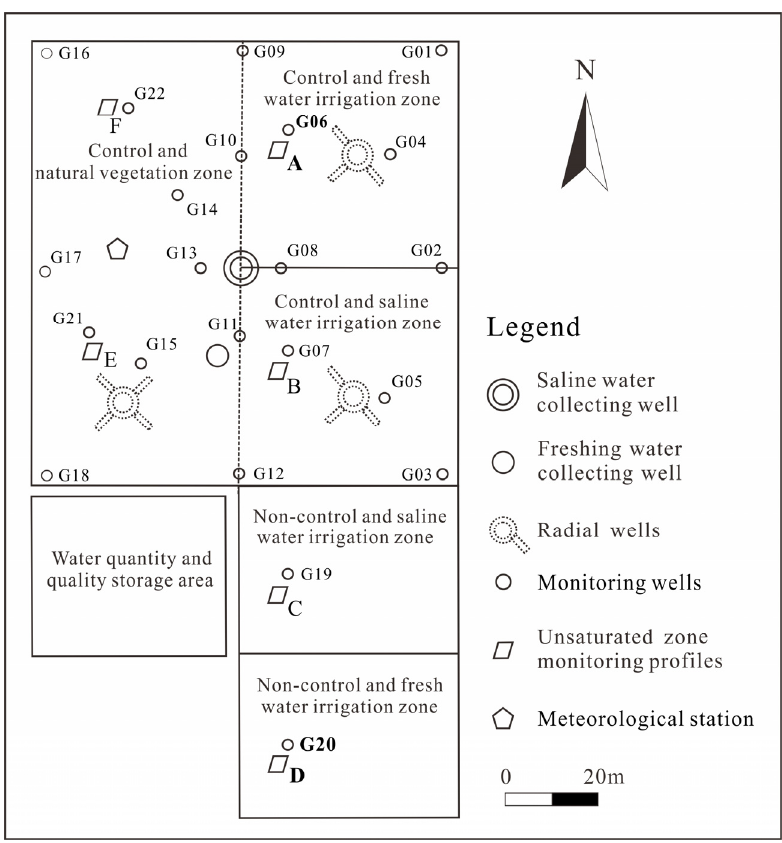
Figure 2. Function zones and monitoring points distribution in the experimental base.